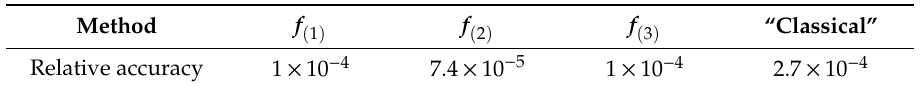
Table 1. Comparison of the relative accuracy of di ff erent methods for determining changes in the refractive index.